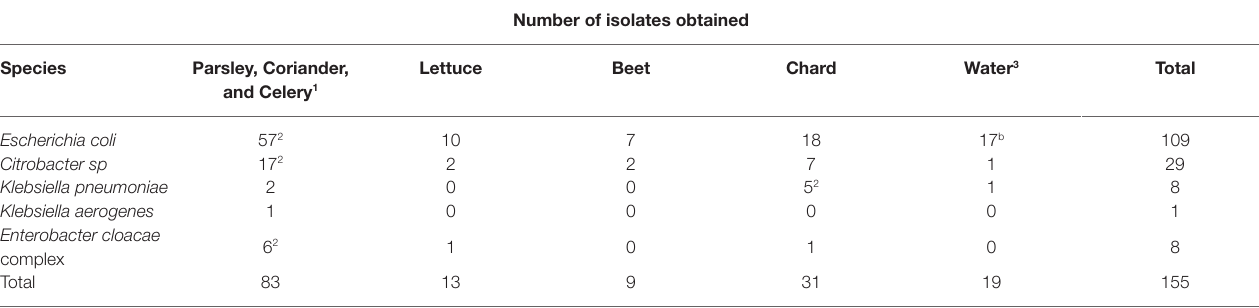
TABLE 2 | Identification and distribution of Enterobacterales strains isolated from vegetable and river samples collected during four seasons during 2019–2020.